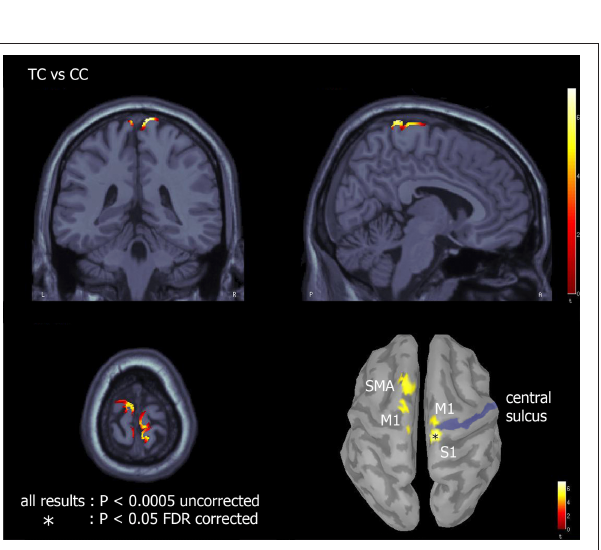
FIGURE 8 | Effect of translation within canonical walkers. Source analysis of the paired t -test between TC and CC showed areas of increased activation for translating with respect to centered condition. The asterisk represents brain regions resulting significant with p < 0.05 and FDR corrected for multiple comparisons; the remaining regions with p < 0.0005